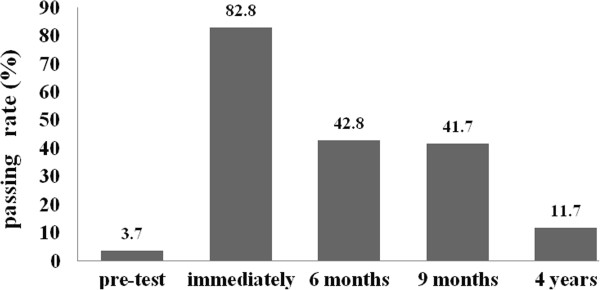
The passing rates at each stage in PedFACTs.